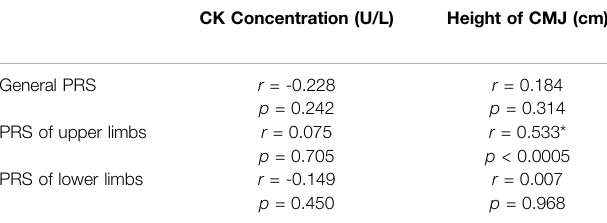
TABLE 2 | Correlation of creatine kinase (CK) concentration, height of counter movement jump (CMJ) and perceived recovery scales (PRS). CK Concentration (U/L)